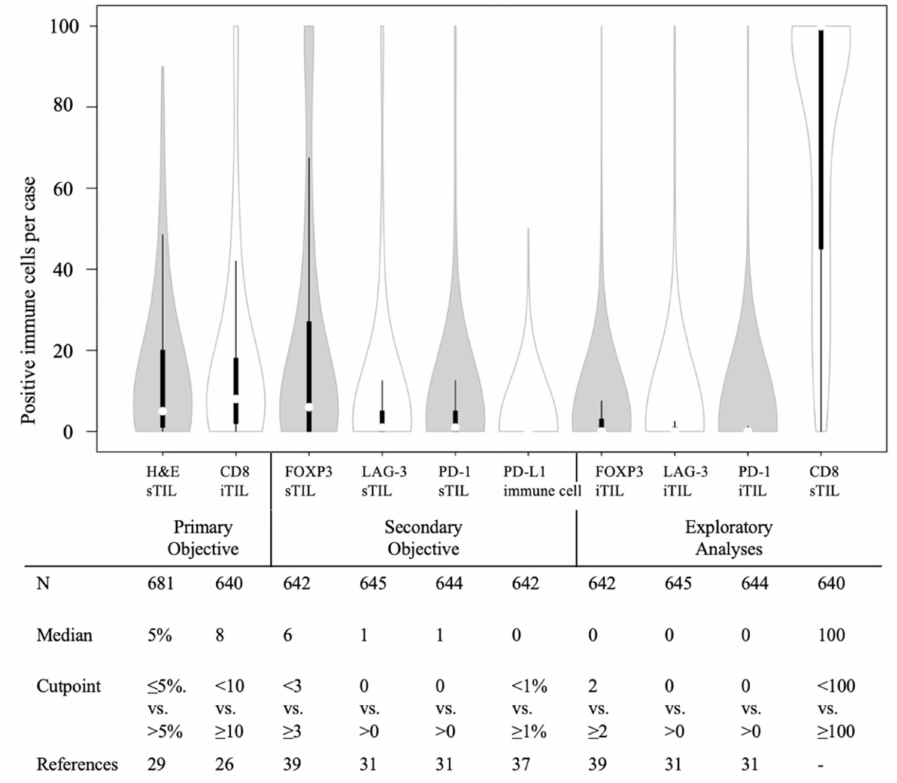
Figure 2. Violin plot showing the distribution of immune biomarkers, with the table summarizing the median values and predefined cut points, obtained from previous studies. White dots represent the median value for each marker. H&E sTIL was included in the primary objective as a continuous vari- able and in the exploratory analysis as a categorical variable. Cutoff point for CD8 iTIL was adjusted for the core size differences between this study (2.0 mm) and previous papers (0.6 mm). Median value was used as a cutoff point for CD8 sTILs. N: number of evaluable cases, H&E: hematoxylin and